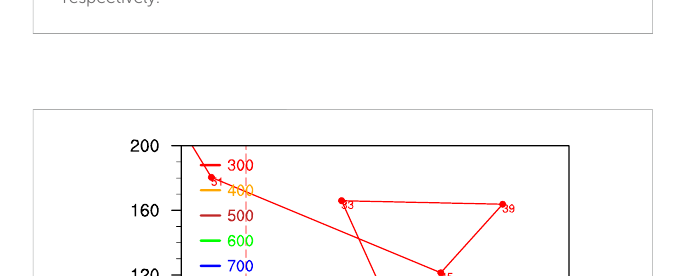
FIGURE 2 Initial surface tangential wind pro fi les in EXP300 (red), EXP400 (orange), EXP500 (brown), EXP600 (green), EXP700 (blue), and EXP800 (purple).